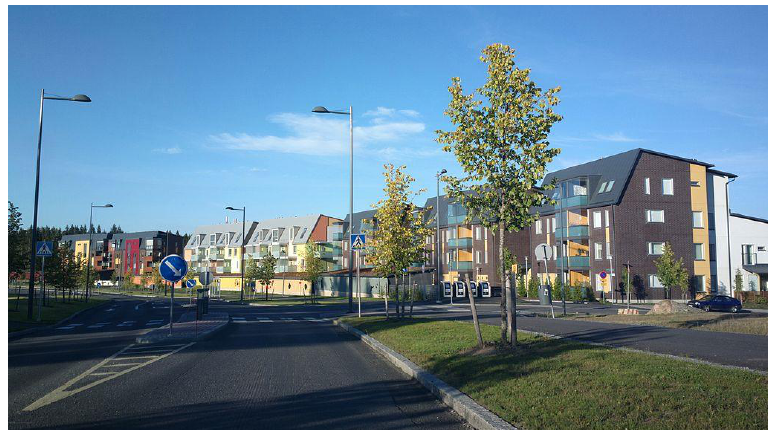
Figure 3. Vuores (source: Wikipedia).